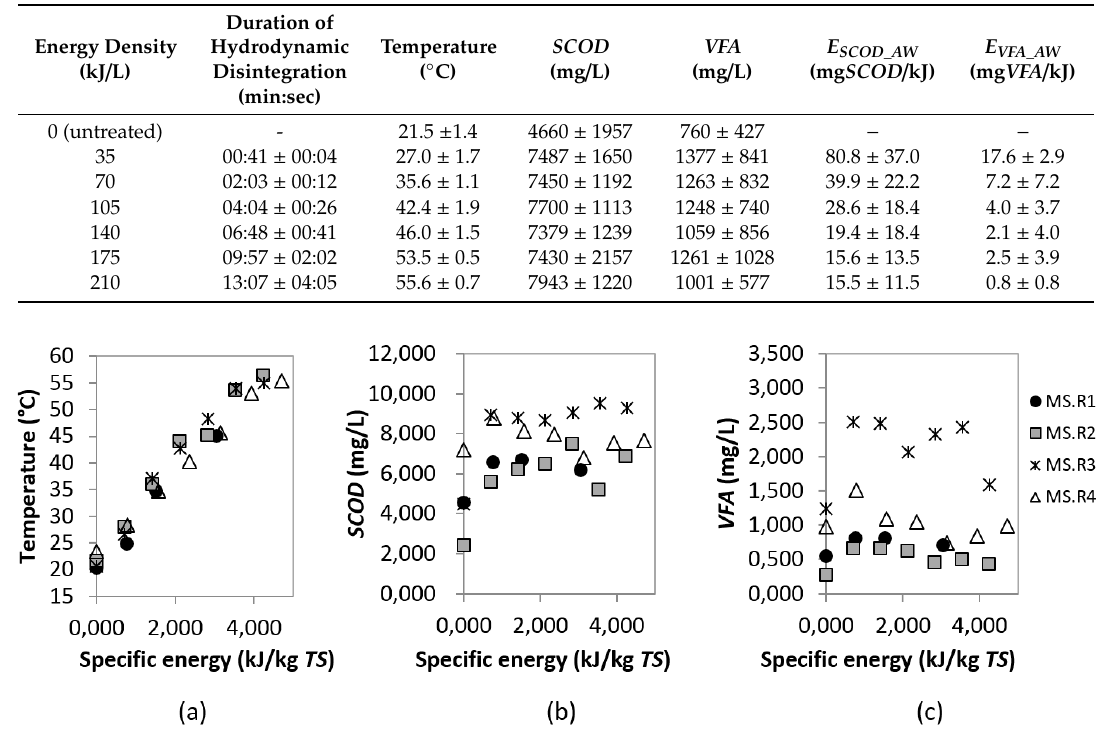
Table 2. Disintegration e ff ect with a given level of energy density for maize silage.